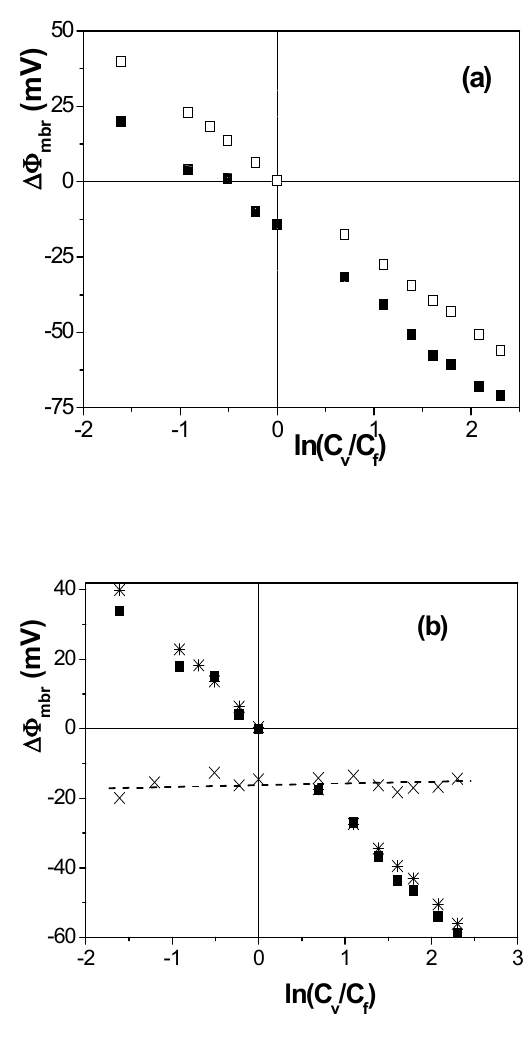
Figure 7. ( a ) Comparison of membrane potential with solution concentration ratio for Ox- NPAM/TiO 2 ( ◊ ) and Ox-NPAM/TiO 2 (f) ( ♦ ) membranes. ( b ) Comparison of experimental () and calculated (solid line) values, Donnan (dashed-dot line), and diffusion (dashed line) potential contri- butions for Ox-NPAM/TiO 2 (f) membrane.